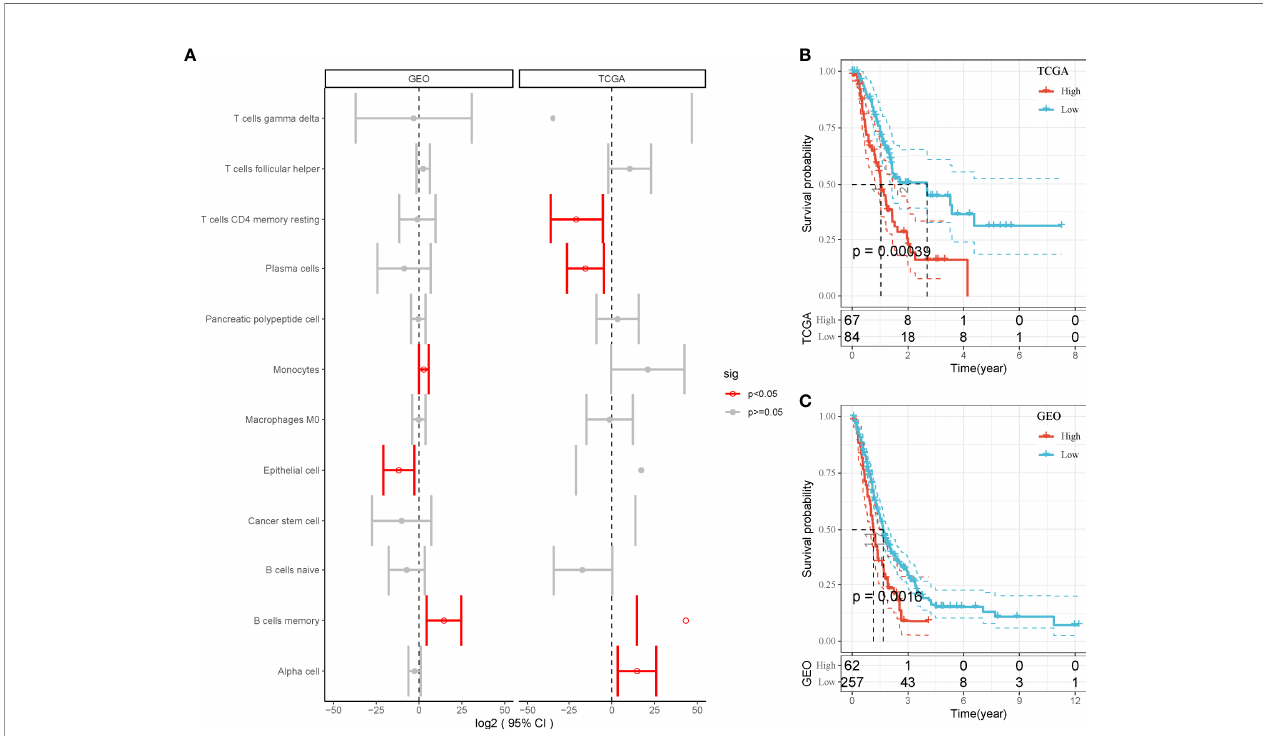
FIGURE 2 | The relation between enrichment of different cell types and PAAD prognosis. (A) Forest plot of different cell types in the relation to prognosis in TCGA and GEO cohorts. Red indicates P < 0.05. (B, C) Kaplan – Meier survival plots of high and low enrichment of MBCs in TCGA-PAAD (A) and GEO (B)